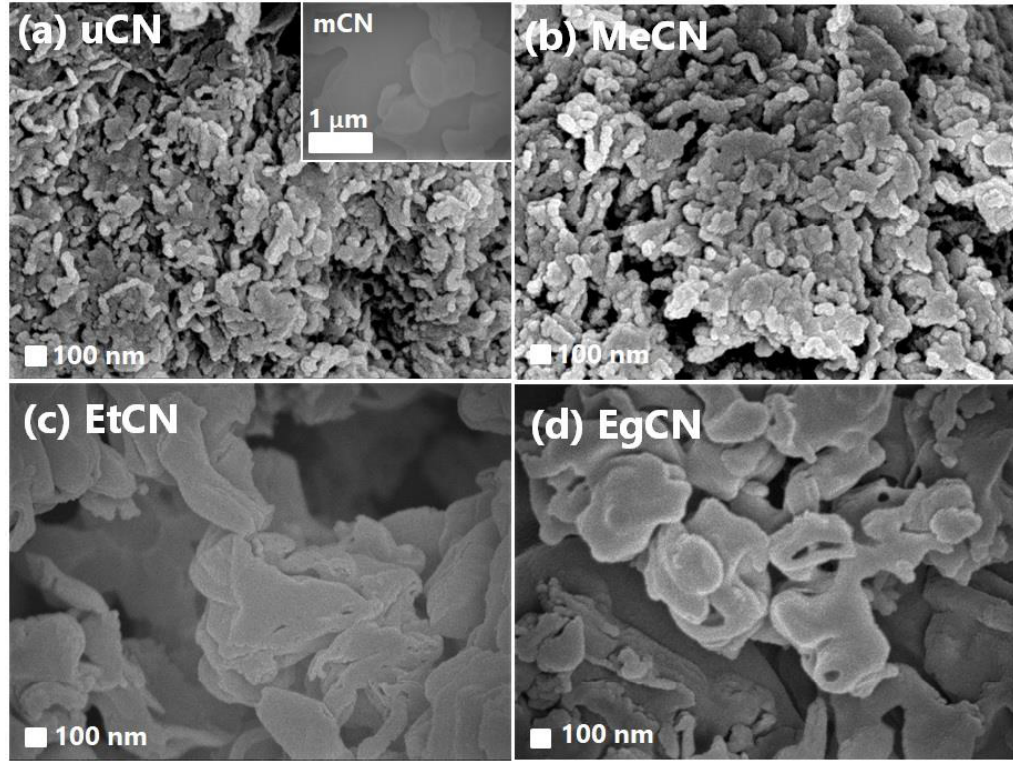
Figure 4. SEM images of ( a ) uCN, ( b ) MeCN, ( c ) EtCN, and ( d ) EgCN samples. Inset of ( a ) shows an image of mCN. image of